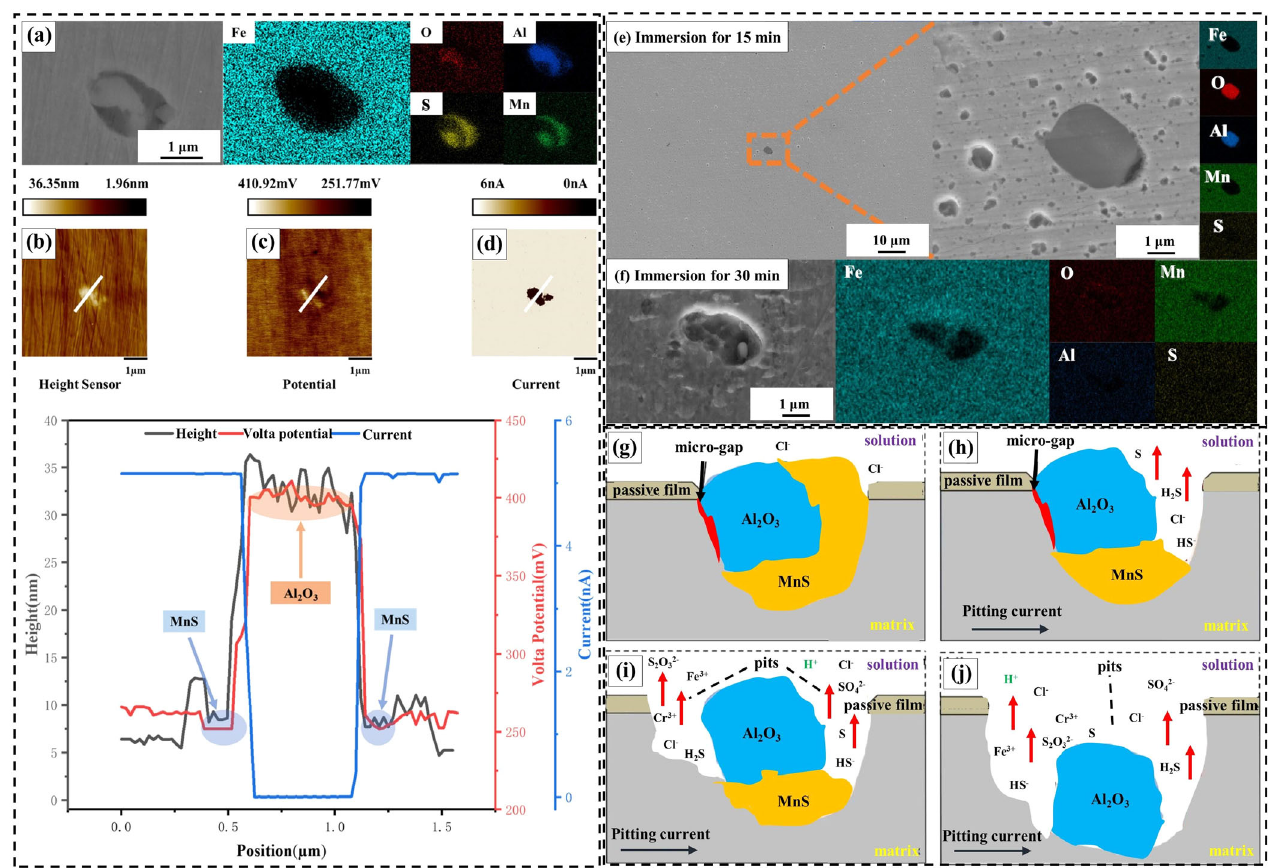
Fig. 14 Characterization measurements and corresponding corrosion evolution diagram for Al 2 O 3 -MnS inclusions in steel. a – d SEM-EDS and micro-electrochemical measurements of Al 2 O 3 -MnS inclusions in steel: a SEM-EDS images, b AFM topography, c Volta potential distribution, and d current distribution. e , f Morphology and composition characterization of Al 2 O 3 -MnS inclusions after immersion in a mixed aggressive solution (1 M NaCl + 0.5 M Na 2 SO 4 + 0.5 M CaCl 2 ) for e 15 min and f 30 min. g – j Schematic diagram of the pit initiation and propagation evolution triggered by Al 2 O 3 -MnS inclusions 16,21